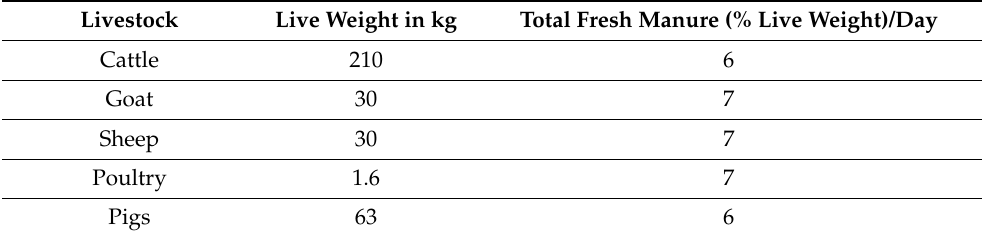
Table 3. Estimated weight of animals and their production of manure expressed as% of body weight. Livestock Live Weight in kg Total Fresh Manure (% Live Weight)/Day Cattle 210 6 Goat 30 7 Sheep 30 7 Poultry 1.6 7 Pigs 63